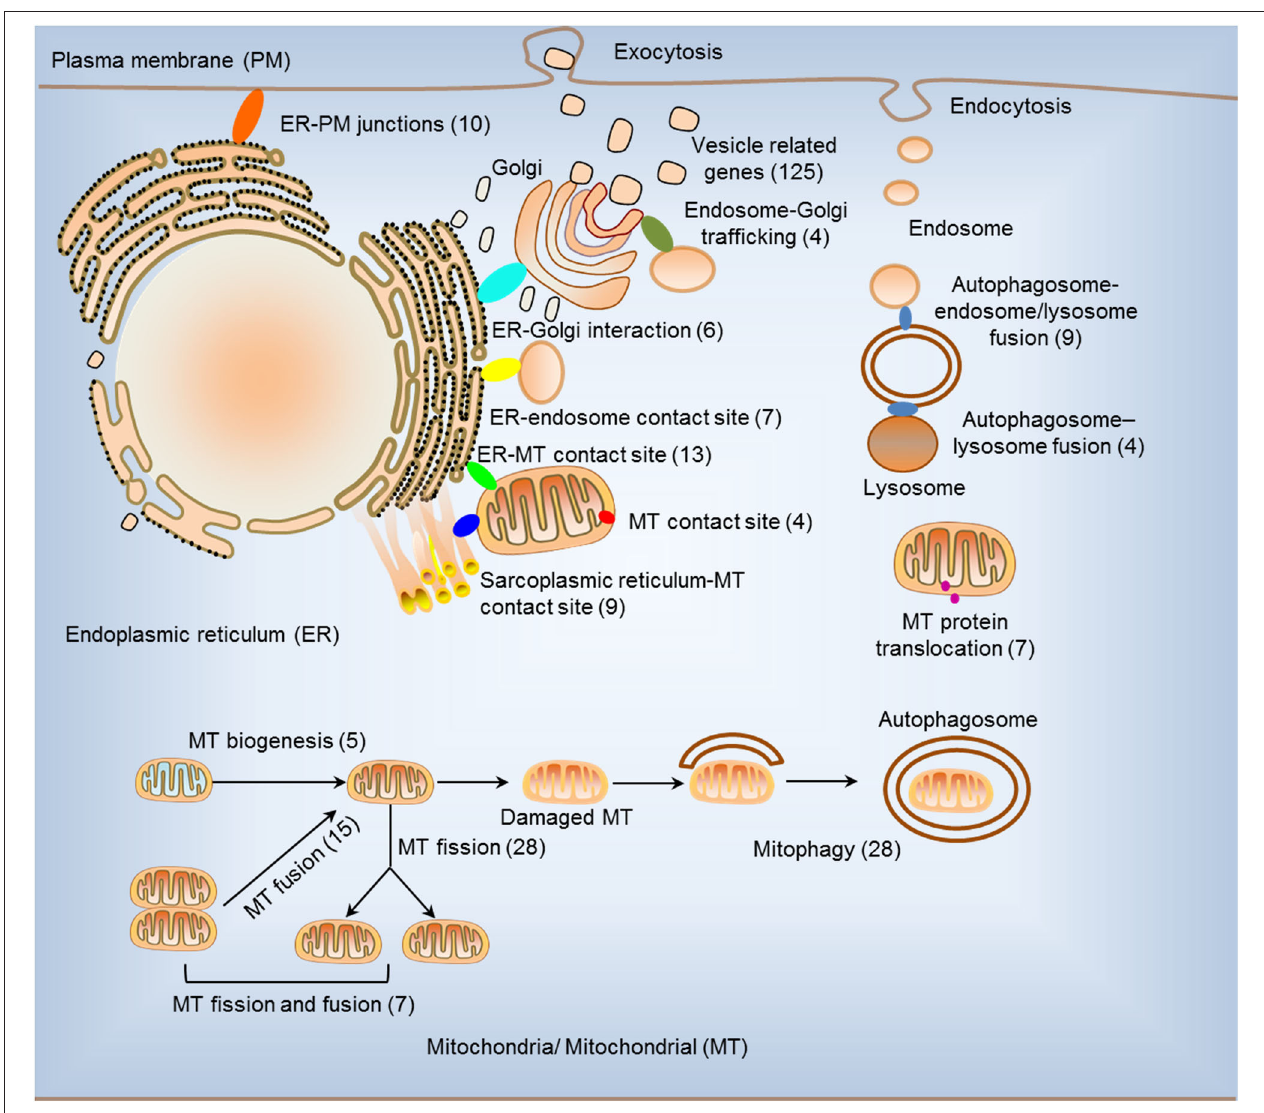
FIGURE 1 | Two hundred sixty organelle crosstalk regulators (OCRGs) in 16 groups were analyzed. There are 16 classification or function of these genes, including nine mitochondria (MT)-related gene populations: MT biogenesis (five genes), MT fusion (15 genes), MT fission (28 genes), MT fission and fusion (seven genes), mitophagy (28 genes), ER–MT contact site (13 genes), MT contact site (four genes), sarcoplasmic reticulum–MT contact site (nine genes), and MT protein translocation (seven genes); three endoplasmic reticulum (ER)-related populations except ER–MT contact site: ER–endosome contact site (seven genes), ER–Golgi interact genes (6), and ER–PM junctions (10 genes); endosome–Golgi trafficking (four genes); autophagosome–lysosome fusion (four genes); autophagosome–endosome/lysosome fusion (nine genes); vesicle-related (125 genes) coded proteins are enhanced by the Human Protein Atlas. Because some genes have more than one function, the final selection is 260 non-repetitive genes. The detailed gene list is in Table 1 .